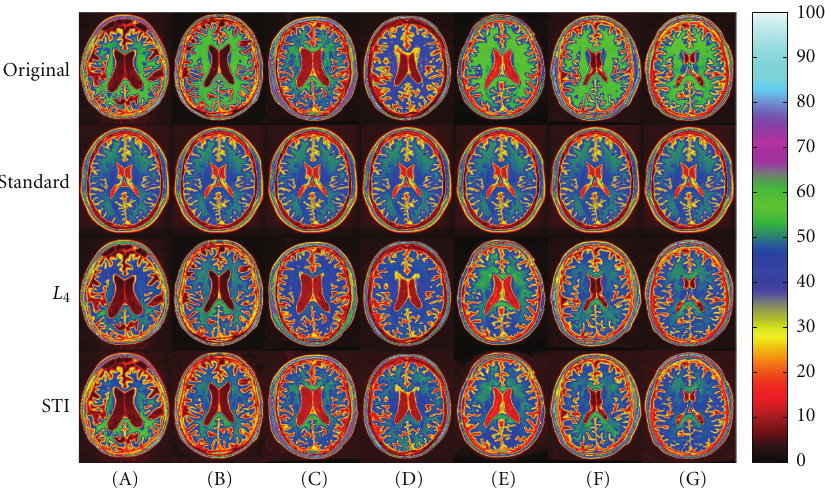
Figure 7: Standardized images of the ADNI dataset, sorted according to MAE percentiles (A) 100, (B) 90, (C) 75, (D) 50, (E) 25, (F) 10, and (G) 0 obtained for the FRG voxel set with STI. Images (A) and (G) correspond, respectively, to the highest (worst) and lowest (best) MAE obtained in FRG for STI. From top to bottom: linearly registered input images, standard image, and images standardized with L 4 and STI, respectively. MAE values are given in Table 1.